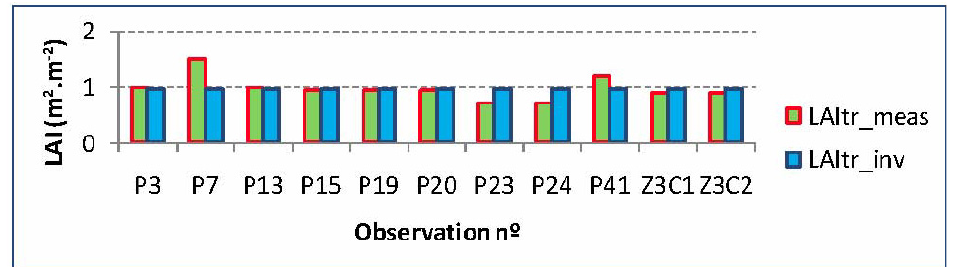
Figure 17. True LAI, measured vs. inverted values.